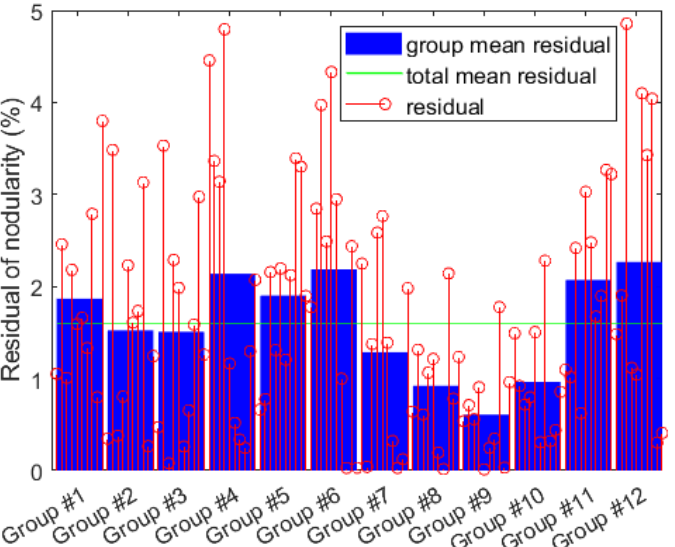
Figure 5. (Color Online) The regression function and its associated 90% confidence bounds of tradi- tional Bayesian regression model from the first week only. ( a ) A cross-section at c T = 3070 m/s, and ( b ) a cross-section at c L = 5606 m/s.